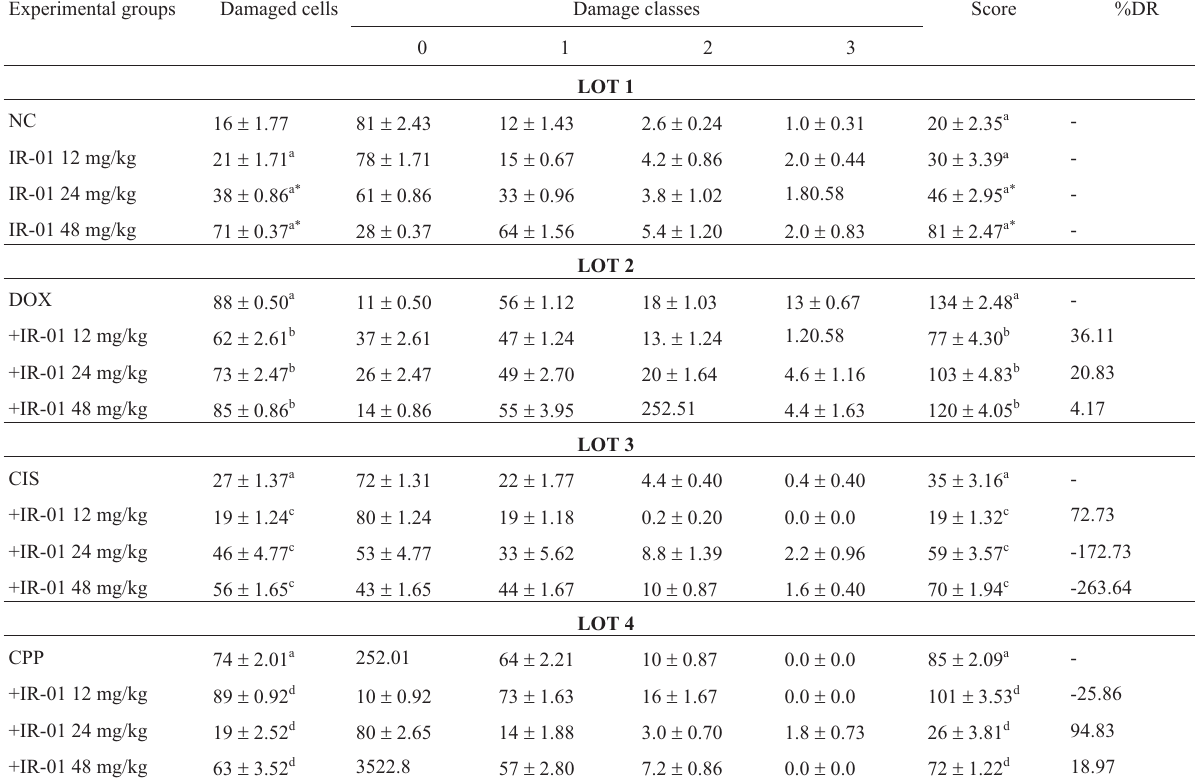
Table 1 - Results of the comet assay showing the ability of IR-01 to cause or prevent genomic damage. Experimental groups Damaged cells Damage